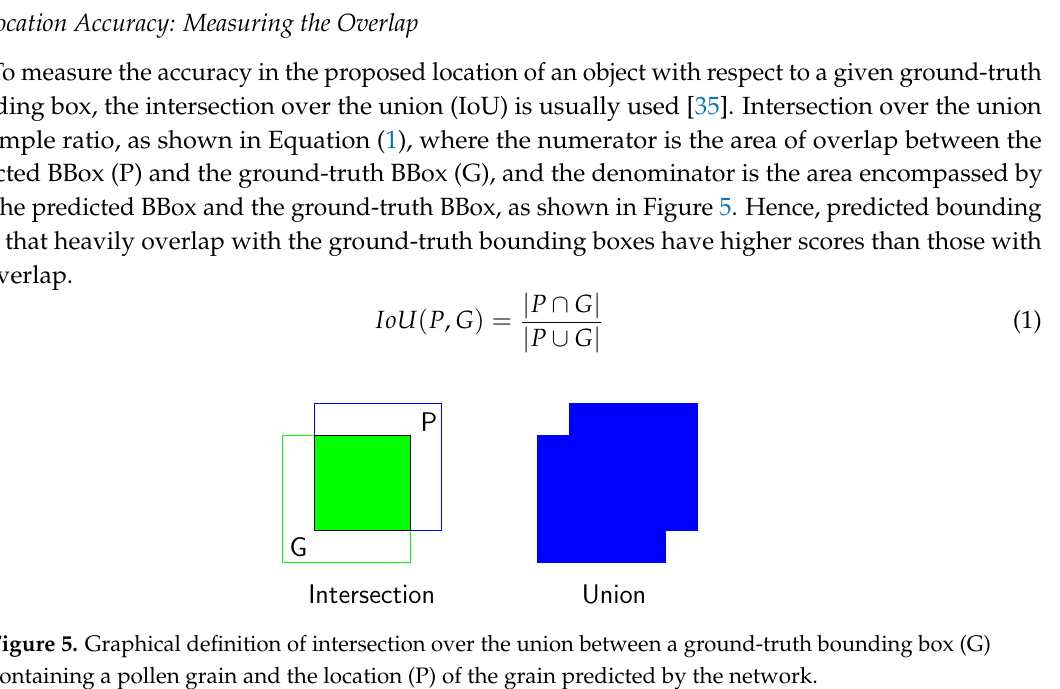
Figure 4. ( a ) Default Faster R-CNN anchors with aspect ratios 1:1 (green), 1:2 (blue), and 2:1 (red). ( b ) Base anchor used in our implementation with aspect ratio 1:1.